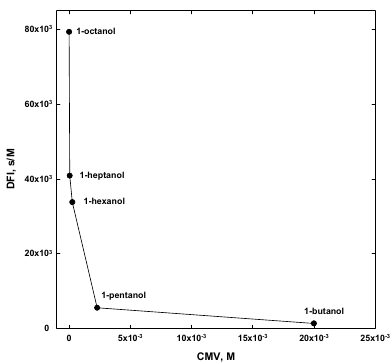
Figure 14. Relationship between dynamic frothability index (DFI) and CMV values for aliphatic alcohols (data: CMV Table 1, DFI [30]).